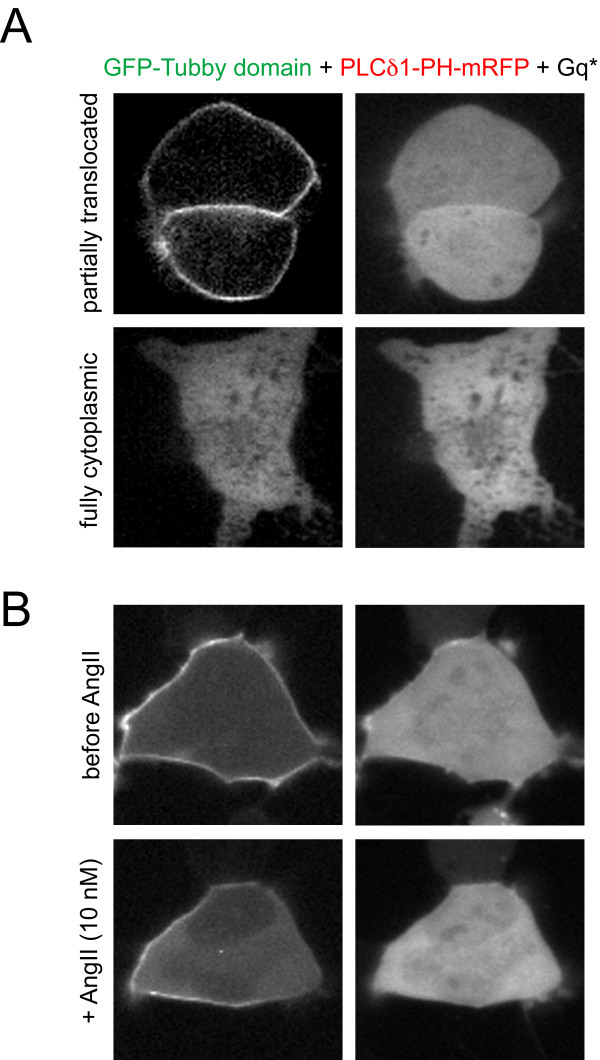
Distribution of the Tubby-domain and PLCδ1PH domain in cells expressing a constitutively active Gq protein. HEK293-AT1 cells were co-transfected with the GFP-Tubby-domain, PLCδ1-PH-GFP plasmids together with a constitutively active Gq α-subunit (Q209L). Panel A shows cells in which the PLCδ1-PH localization is completely lost while that of the Tubby domain is still quite substantial (upper) while in some cells both construct completely lose membrane localization (lower). Panel B shows an example where a cell that still shows substantial localization of the Tubby domain loses its PM localization after stimulation with even a low concentration (10 nM) of AngII.